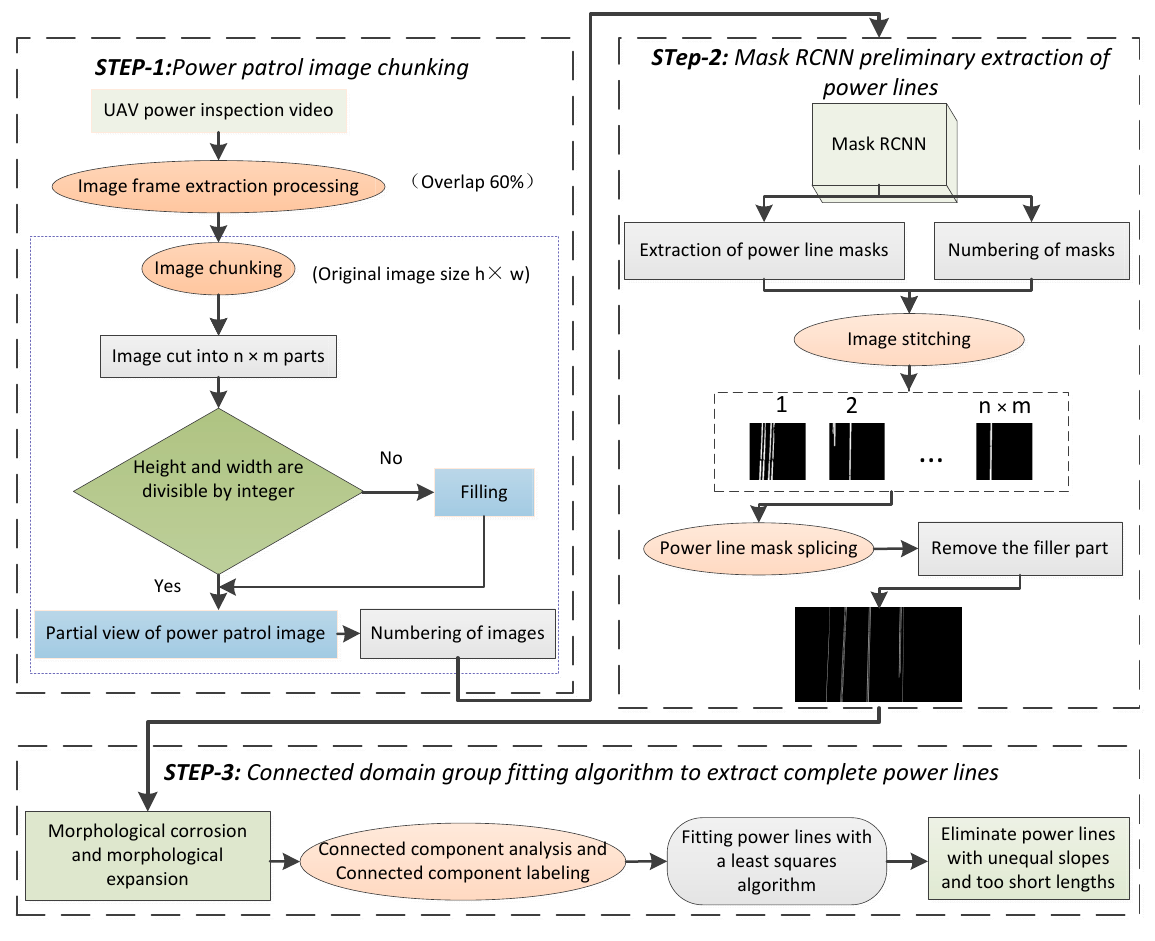
Figure 3. Automatic extraction technology of power lines from UAV aerial images.